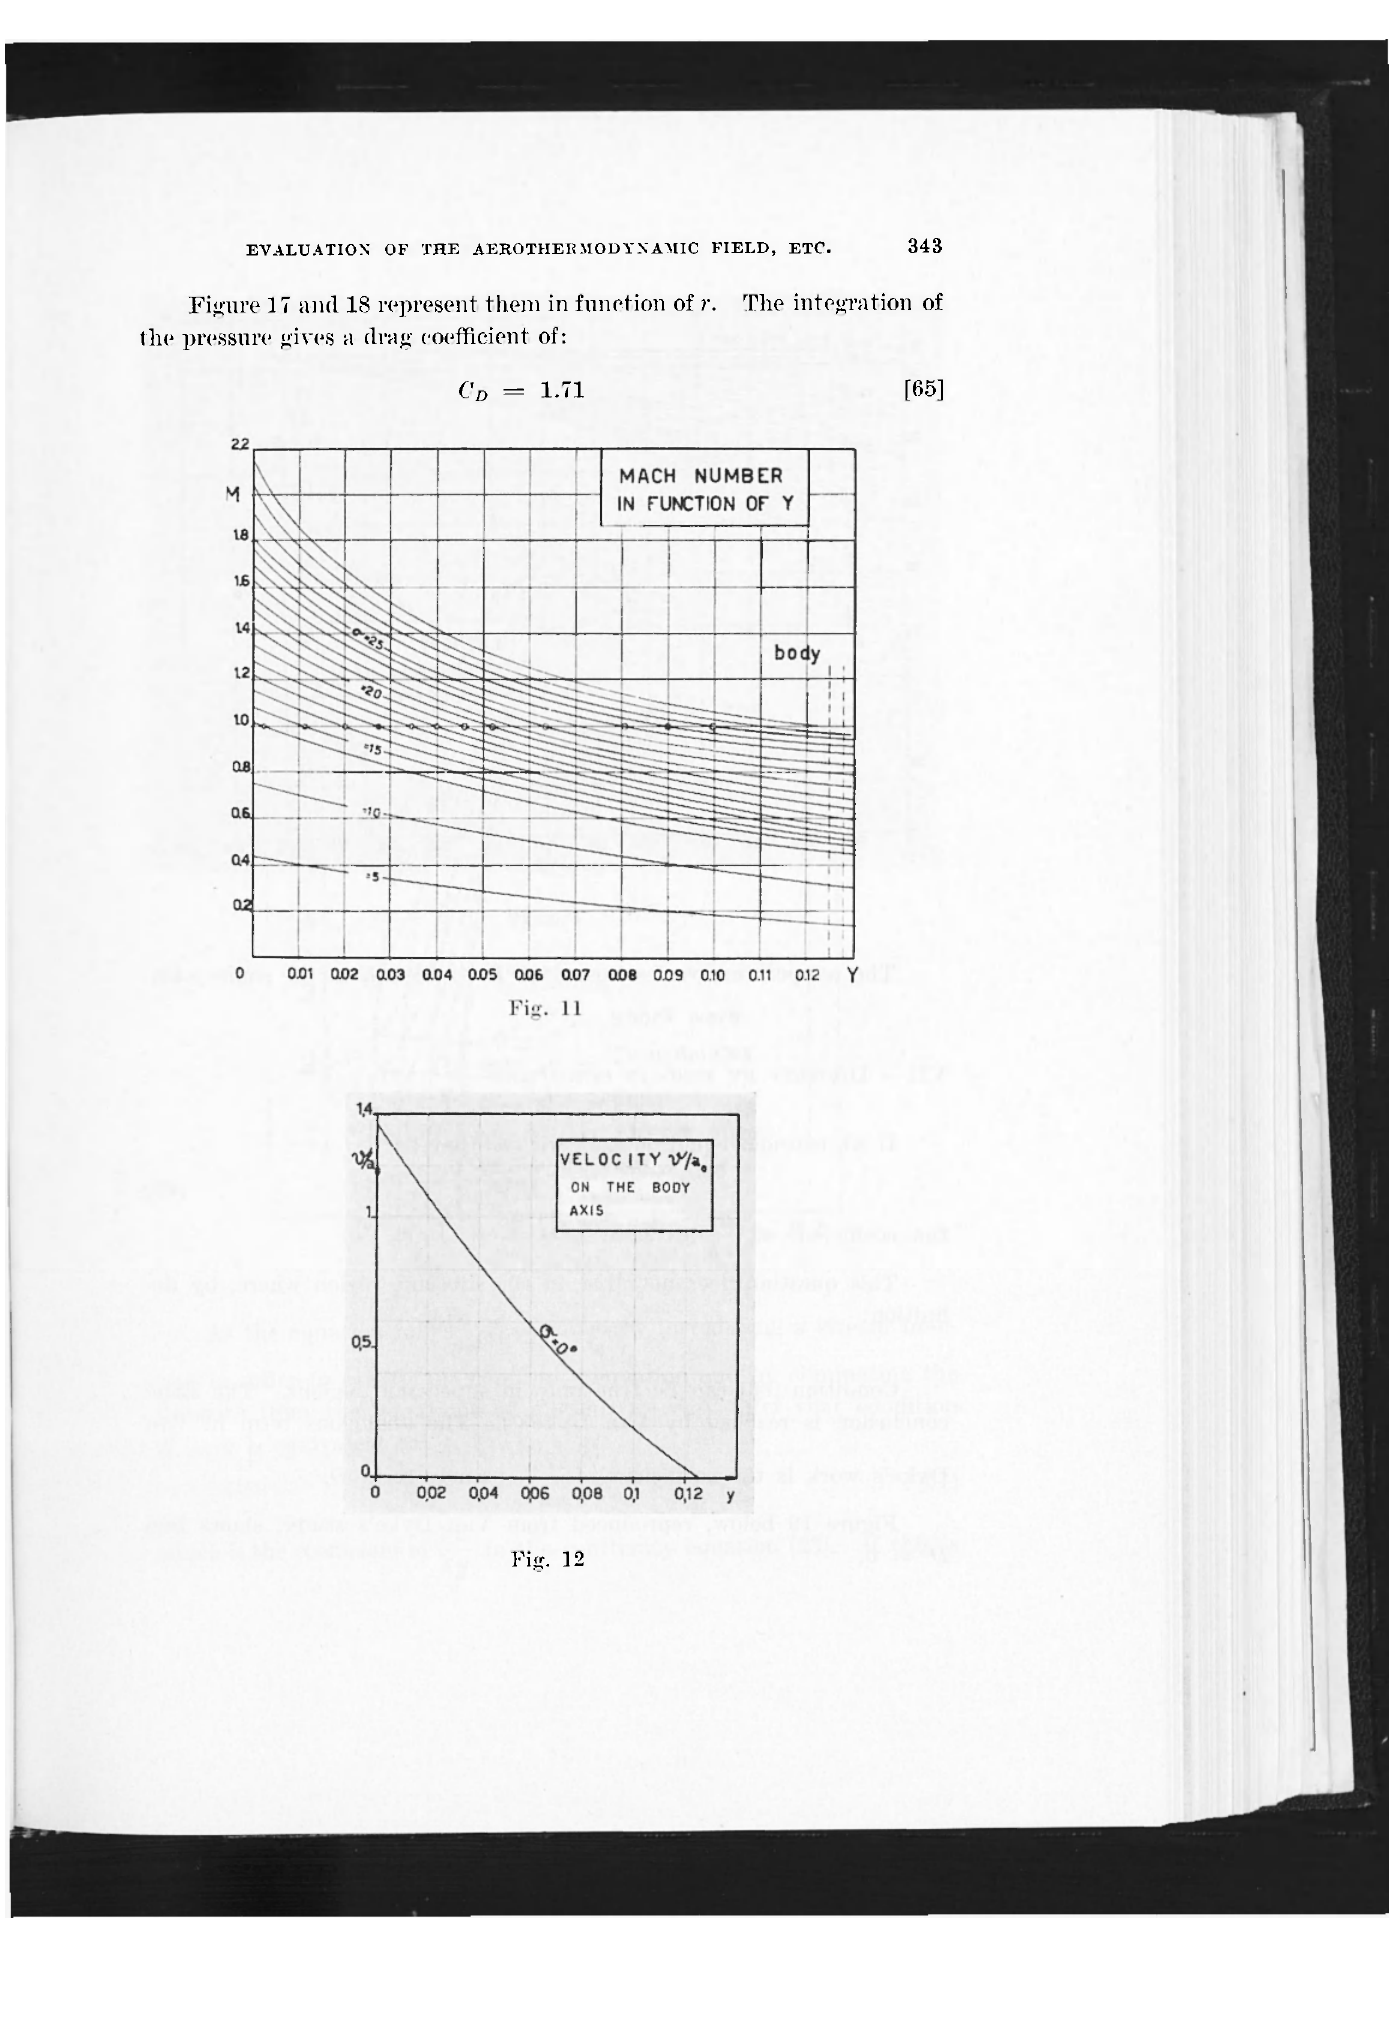
Figure 1 7 and 18 represent them in function of r. The integration of the pressure gives a drag coefficient of: C D =